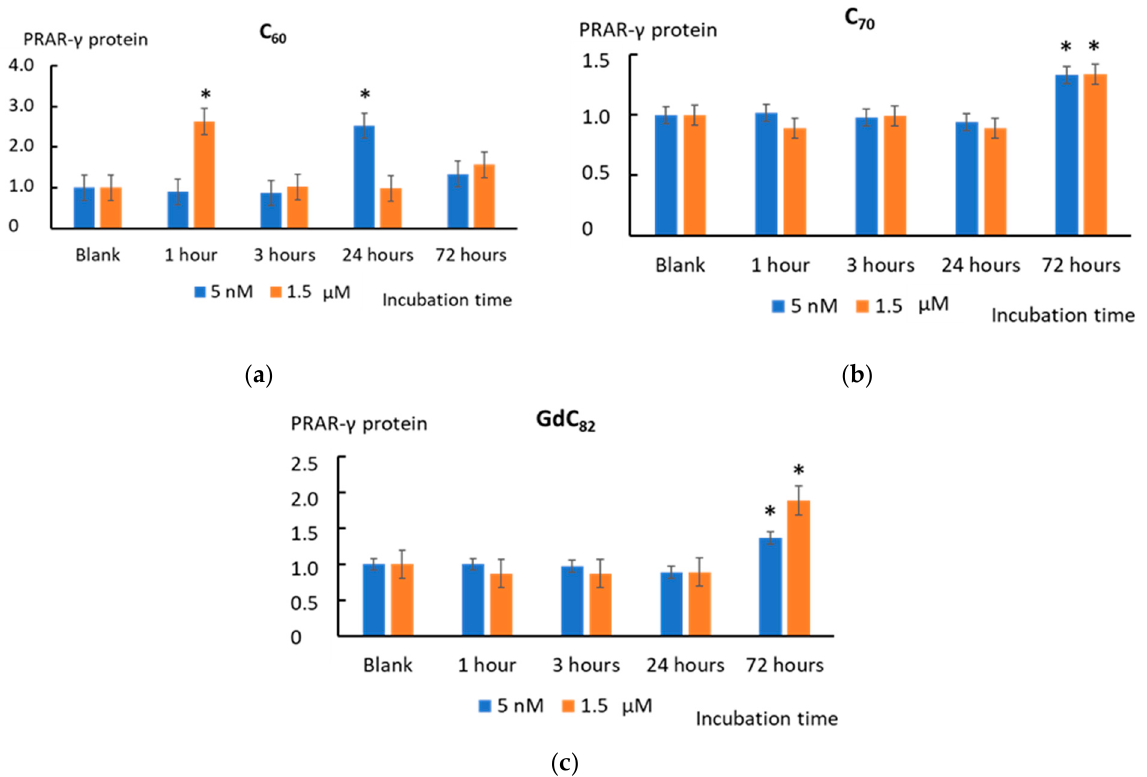
Figure 9. The PRAR- γ protein level in cells treated with ( a ) C 60 , ( b ) C 70 , and ( c ) Gd@C 82 at concentrations of 5 nM and 1.5 µM. The blank cells were incubated without the AFDs. (*) denotes significant differences with the blank cells, p < 0.01, a nonparametric U-test.